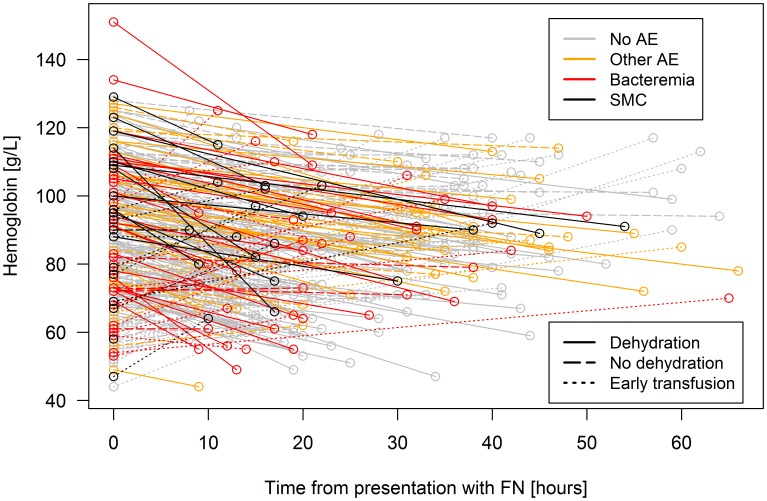
Course of hemoglobin used to calculate Hb-ratio.Hemoglobin at presentation, and within 72; AE, adverse event; SMC, serious medical complication.